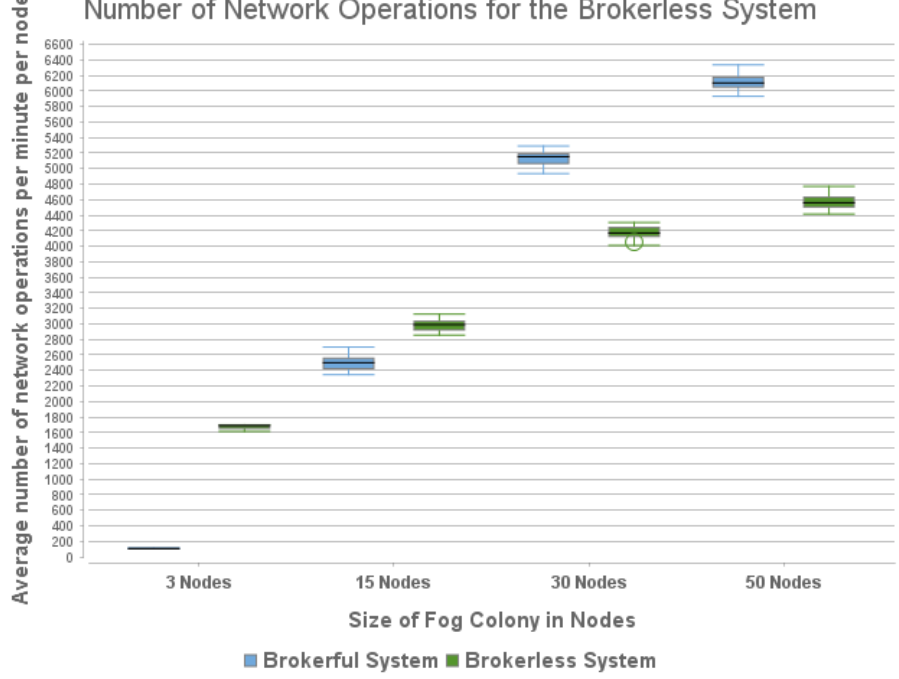
Figure 9. Box chart showing the comparison on the network operations per minute per node between the two Fog Colony